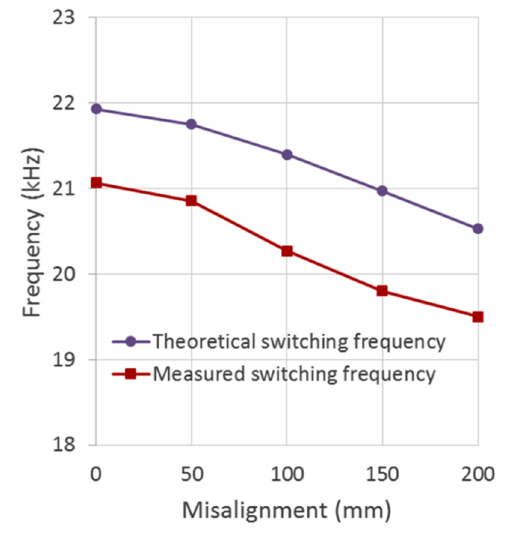
Figure 9. The theoretical and acquired switching frequencies for uniform voltage gain control with various couplings (misalignment at an air gap of 100